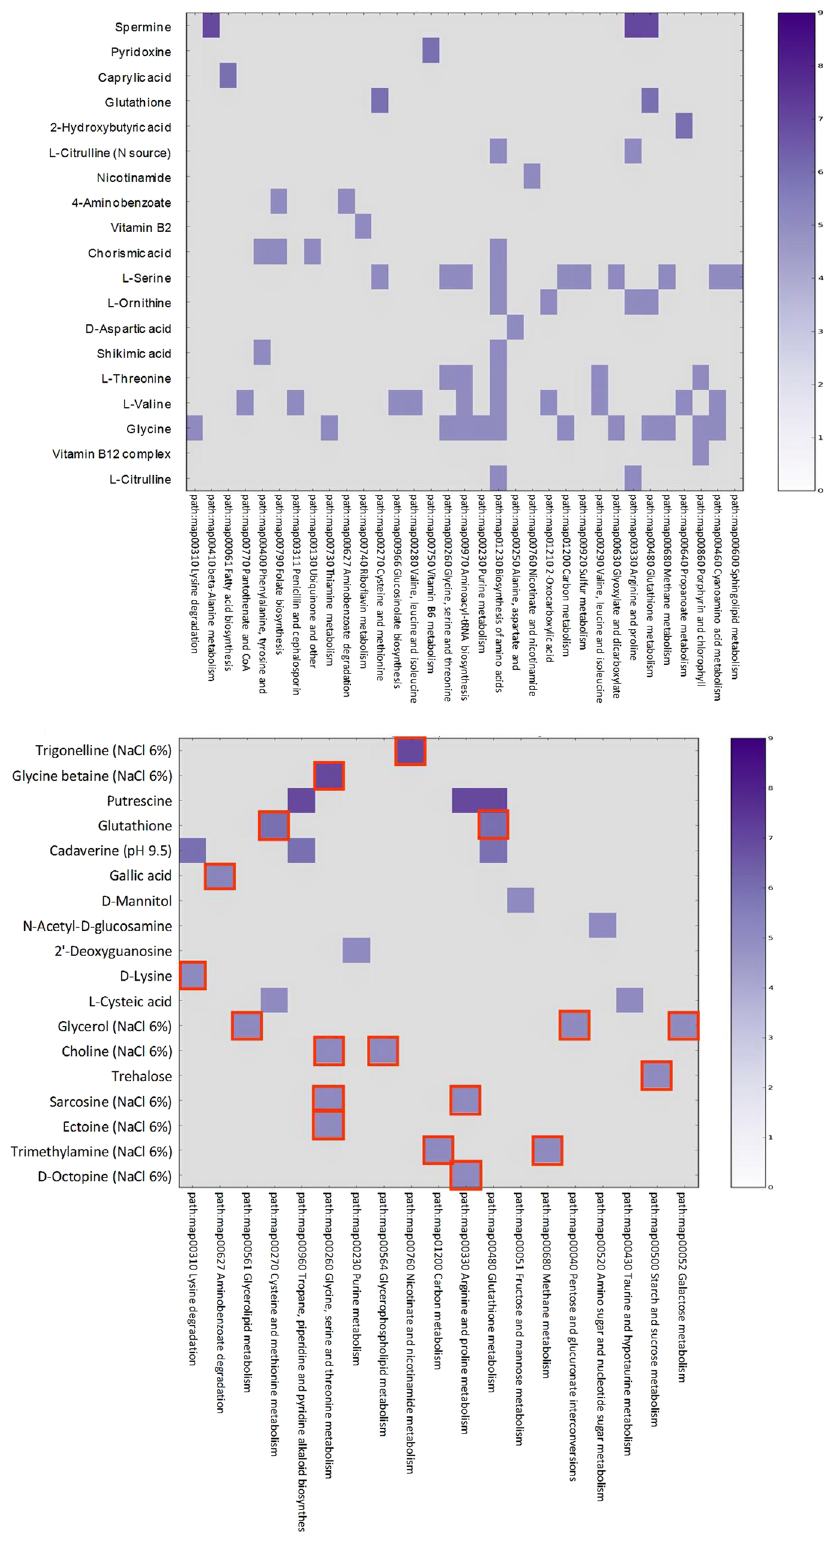
Figure 5. Combined genome/phenome variability of PhTAC125 and PspTB41 (red-border squares) strains at 4 °C (a) and 15 °C (b). The main PM substrates (AV > 5) which were differently used by the two strains are reported on the Y axis whereas the metabolic pathways involved are reported on X axis. The color indicates the magnitude of such AV difference